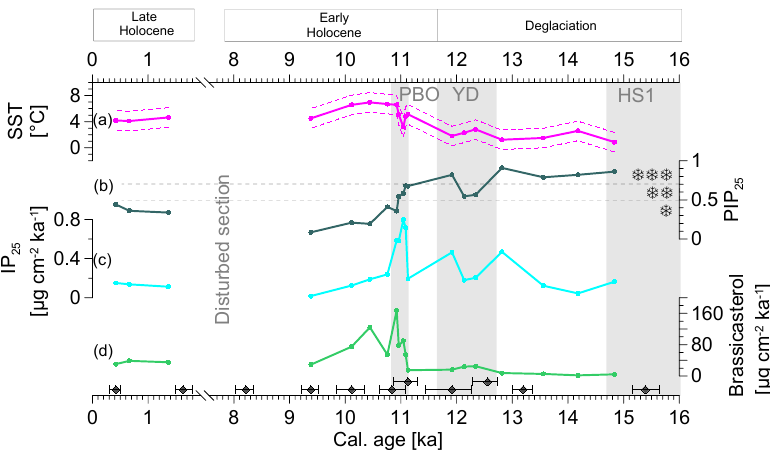
) (Brassell et al., 37